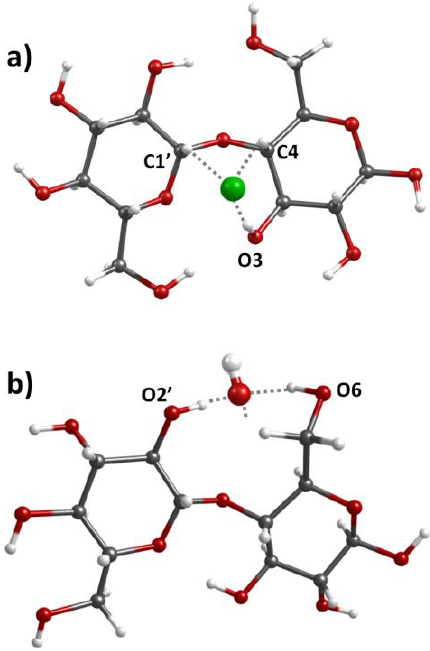
Figure 9. ( a ) Lowest energy optimized structure of the cellobiose-chloride model. The contacts are O(3)–H···Cl (205 pm), C(4)–H···Cl (260 pm) and C(1’)–H···Cl (266 pm) and ( b ) example of the